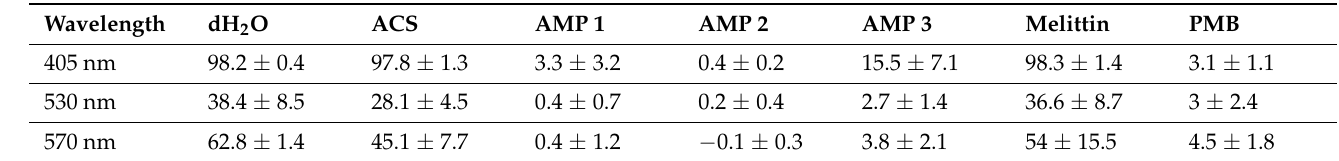
Figure 6. OD measurements of free hemoglobin in human whole blood at 405 nm ( A ), 530 nm ( B ), or 570 nm ( C ). Samples were treated with PBS (negative control), AMPs 1, 2, 3, melittin, or polymyxin B (all at 100 µ M), as well as with dH 2 O, ACS, or different concentrations of Triton X-100, Tween, or SDS. All samples were incubated for 60 min at 37 °C. Average values from three experimental replicates, each containing two technical replicates, are presented with error bars (SD) included in plots. Table 5. Calculated hemolysis ratios according to Equation (1) for AMPs 1, 2, 3, melittin or polymyxin B (PMB) (all at 100 µ M) as well as for dH 2 O or ACS from measurements at 405, 530 and 570 nm on human whole blood. Measurements from samples with 10% SDS (positive control) or 10% Triton X-100 (positive control at 570 nm) and PBS (negative control) were used as 100% and 0% hemolysis for the normalization. Normalization was performed on data averaged from three experimental replicates, each containing two technical replicates.